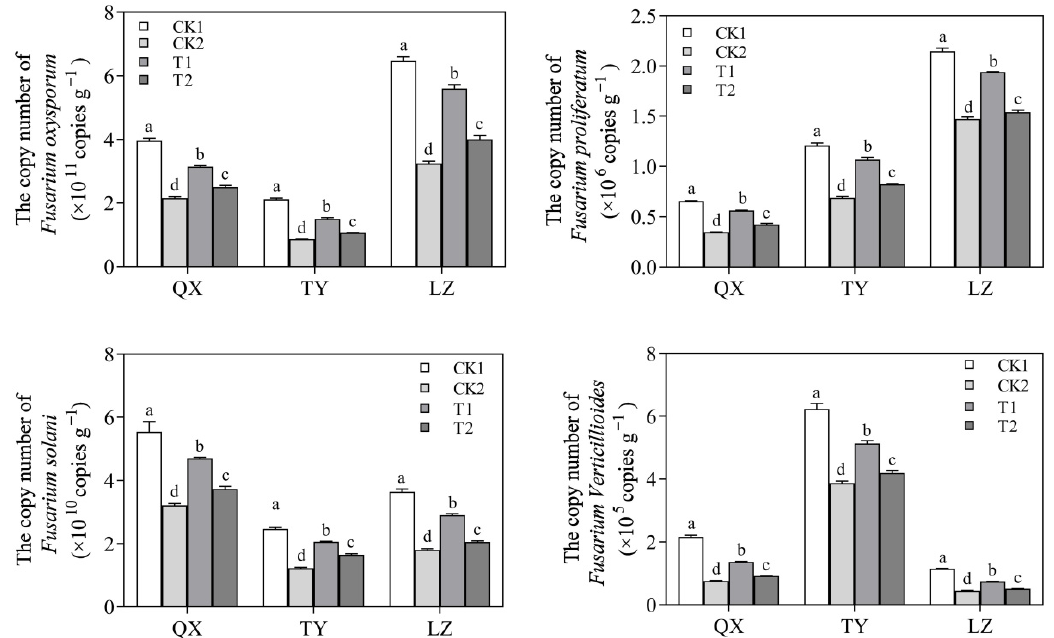
were log10-transformed, and the scale method (from zero to one) was used for the heatmap repre- sentation. Each treatment included three repetitions.